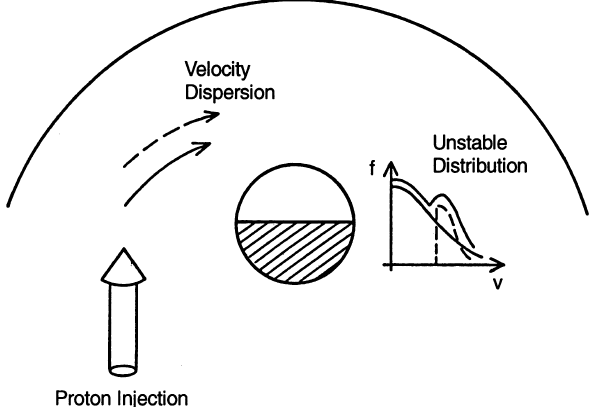
Fig. 8. Schematic representation of proton injection, velocity dispersion, and resulting unstable particle phase space density distribution in the dayside